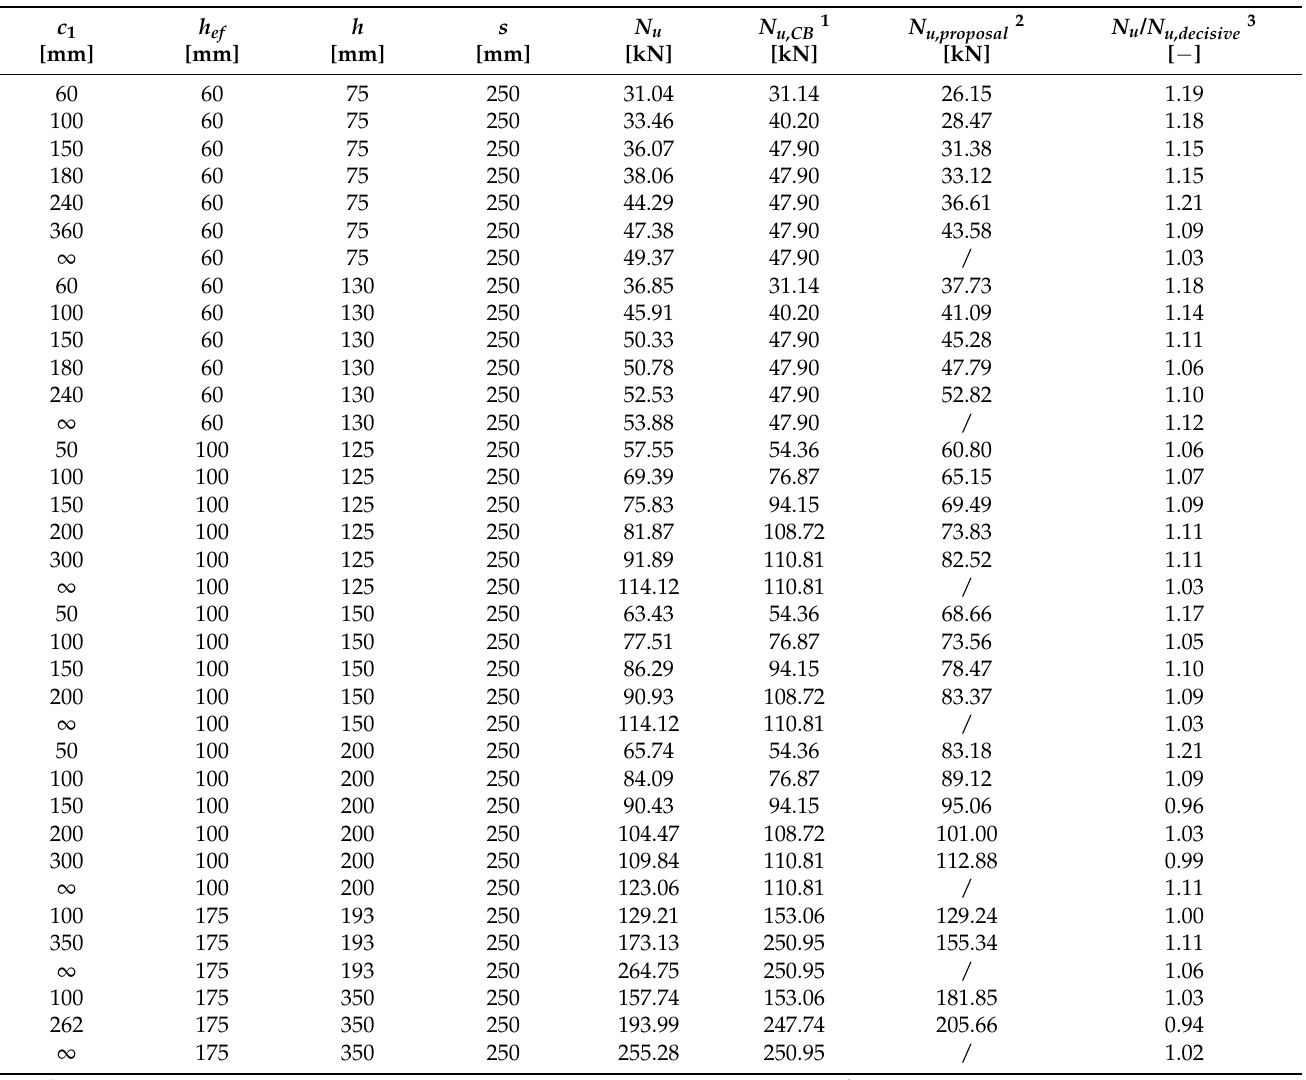
Table A2. Numerical simulations—influence of edge